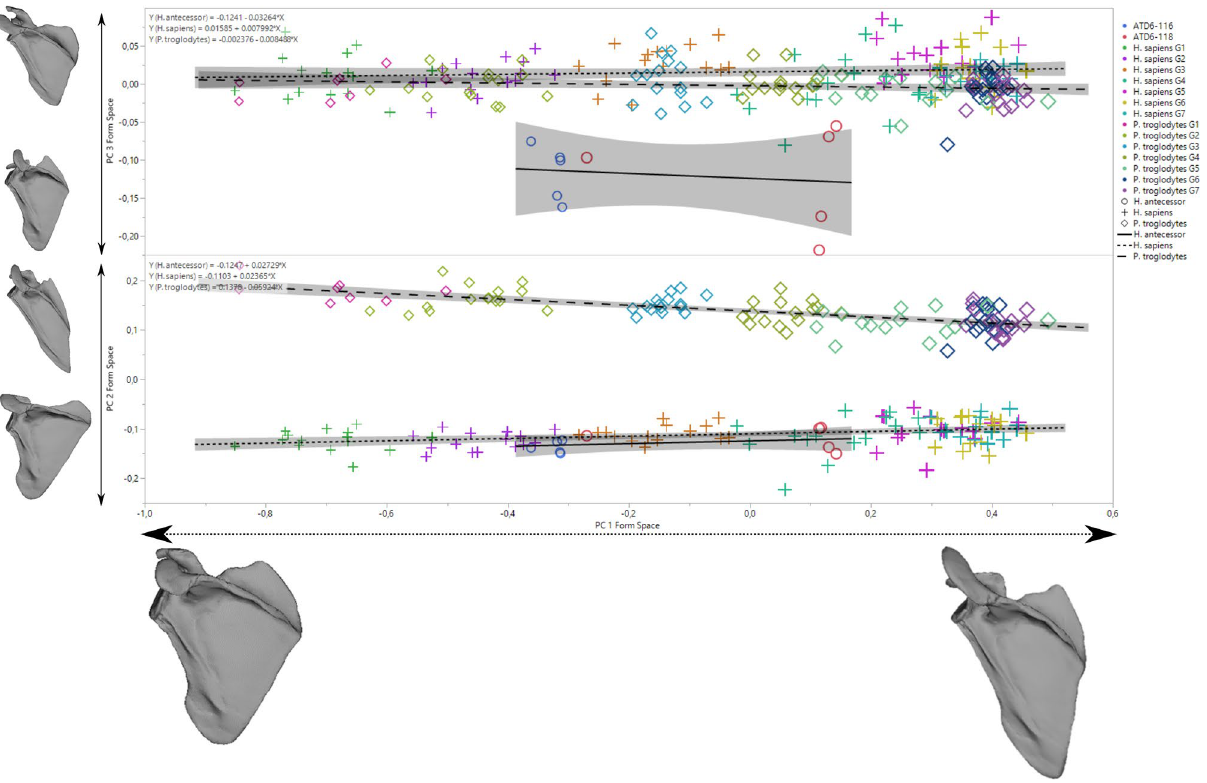
Figure 5. Form space PCA showing ontogenetic trajectories for H. sapiens (“+” symbols), P. troglodytes (“diamond” symbols), and H. antecessor (“circle” symbols). The regression formula and the confidence intervals are shown. Notice that for H. antecessor, all the acromion estimations are depicted (see “Materials and methods”). Different colors depict different age